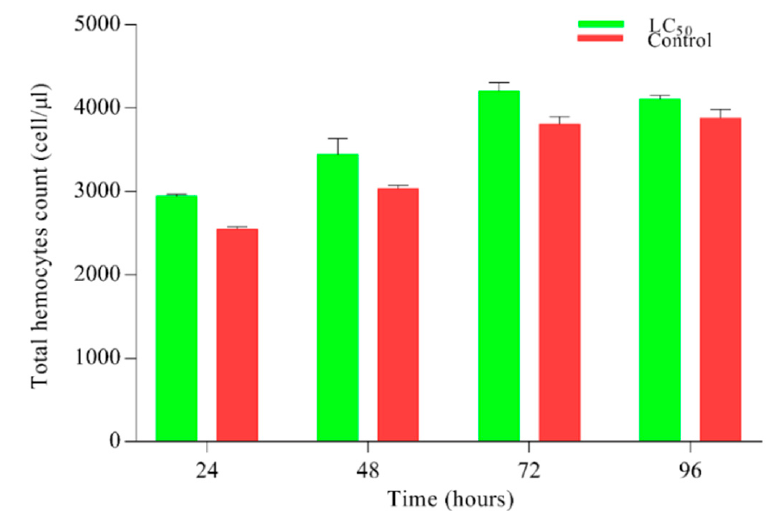
Figure 3. Hemocytes count in Plutella xylostella larvae after treatment with lethal (LC 50 ) concentration of Metarhizium anisopliae . Green bars represent the hemocytes count of larvae under the pressure of LC 50 while red bars show tween control (0.05% aqueous diluted) hemocytes count. Results were statistically non-significant p < 0. 071. Error bars show 95% confidence intervals (CI).